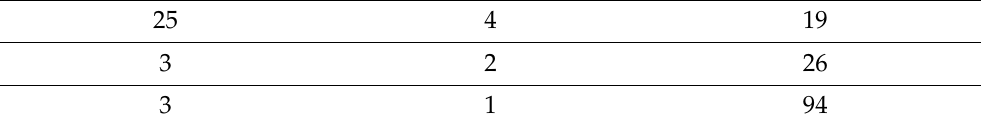
Table 9. Confusion matrix for Glove embedding with the Chi-squared feature selection method; 100 features.